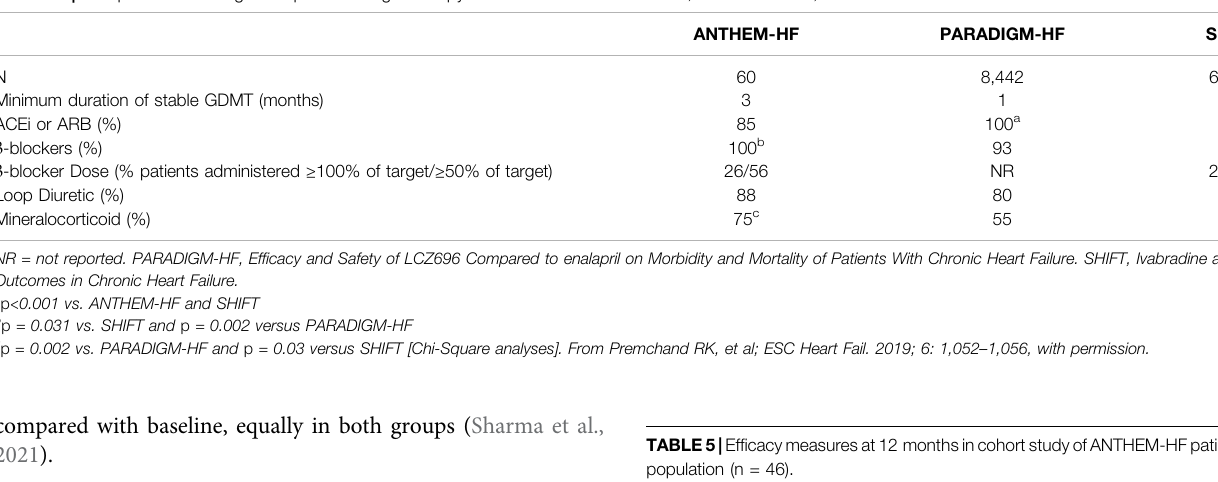
TABLE5| Ef fi cacymeasuresat12 monthsincohortstudyofANTHEM-HFpatient population (n = 46).